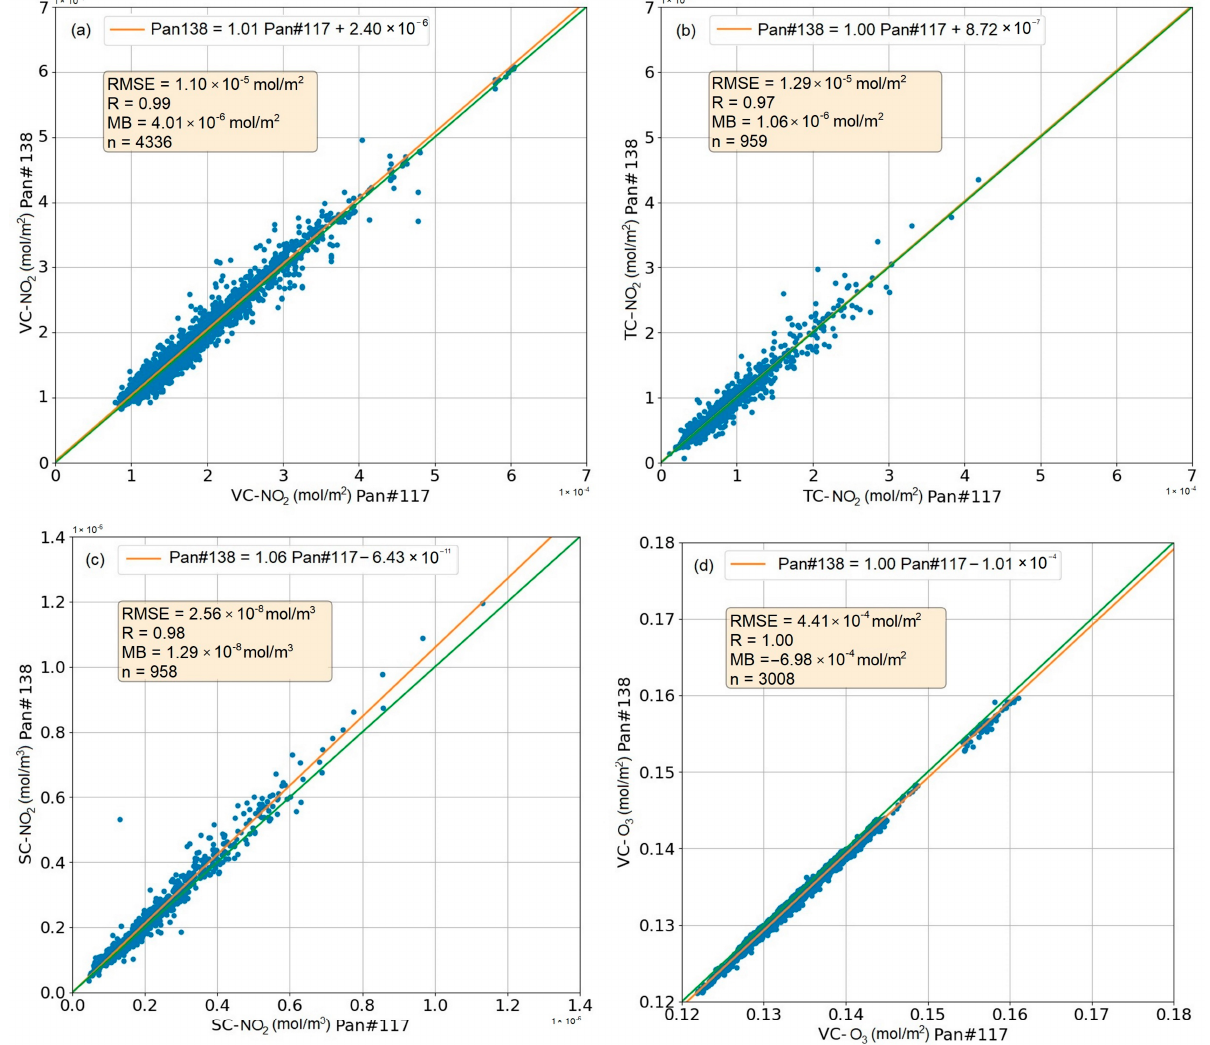
Figure 2. Pan#138 vs. Pan#117 scatter plots for the period 24 July—11 September 2020 ( a ) VC-NO 2 , ( b ) TC-NO 2 , ( c ) SC-NO 2 , and ( d ) VC-O 3 . The reported statistical parameters are root-mean-square of differences (RMSE), linear Pearson correlation coefficient (R), mean bias (MB), and number of valid retrievals (n). Orange lines indicate the linear fit between the two instruments, while green lines indicate the ideal fit 𝑦 = 𝑥 .